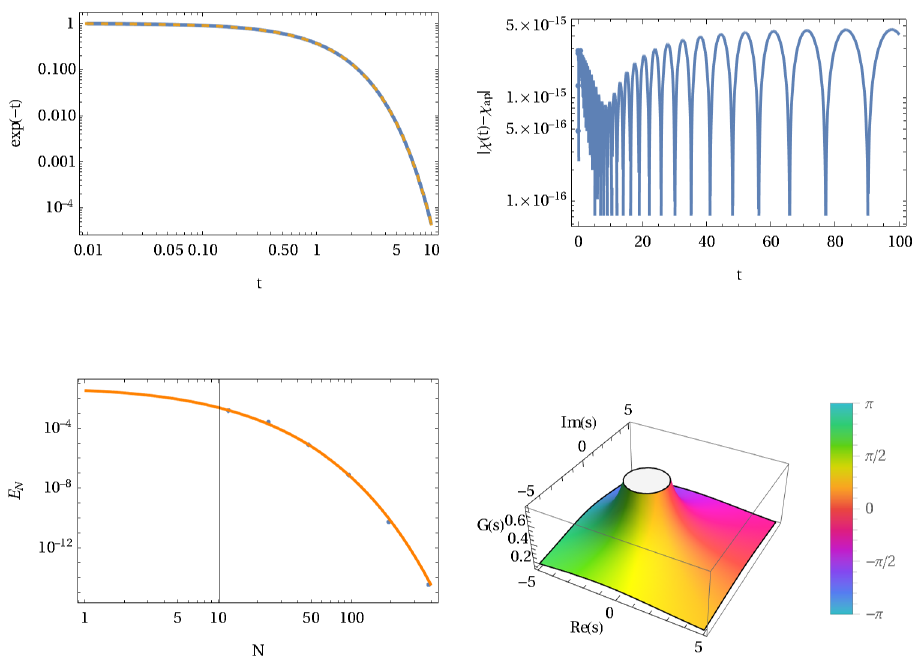
Figure 4. Solution of Debye’s relaxation Equation (84) generated by the Sinc inverse Laplace transform based on indefinite integrals. The top left panel includes the exact solution of the relaxation equation given by χ ( t ) = χ 0 exp ( − ( t / τ )) (dashed) and the approximation (solid line). The top right panel shows the absolute local error of the difference between the exact solution and the approximation. The number of approximation points used in the calculation was m = 2 N + 1 = 769. The parameters to generate the plot are χ 0 = 1 and τ = 1. The bottom panels (left) show the error decay as a function √ (cid:16) (cid:17) 1/2 − k N exp of Sinc points N , E N ∼ . Dots represents numerically determined L 2 norms, and 1 N the solid line represents Equation (57) with c = 0, where K 1 and k 1 are adapted accordingly. The right panel shows the structure of the transfer function G ( s ) on the complex plane C